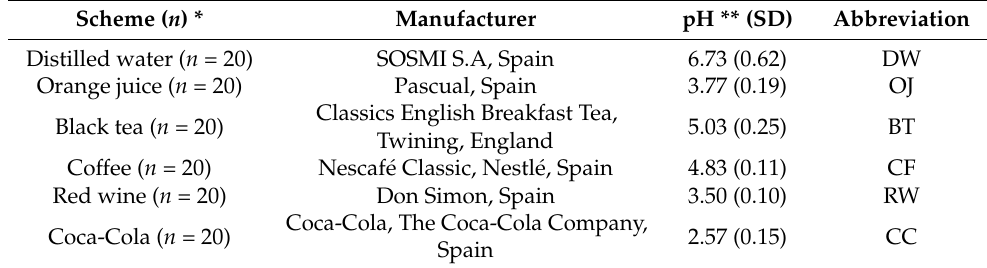
Table 2. Staining solutions used in the study.